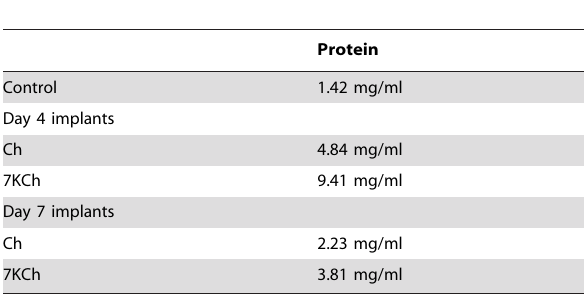
Table 1. Protein concentration of aqueous humor.